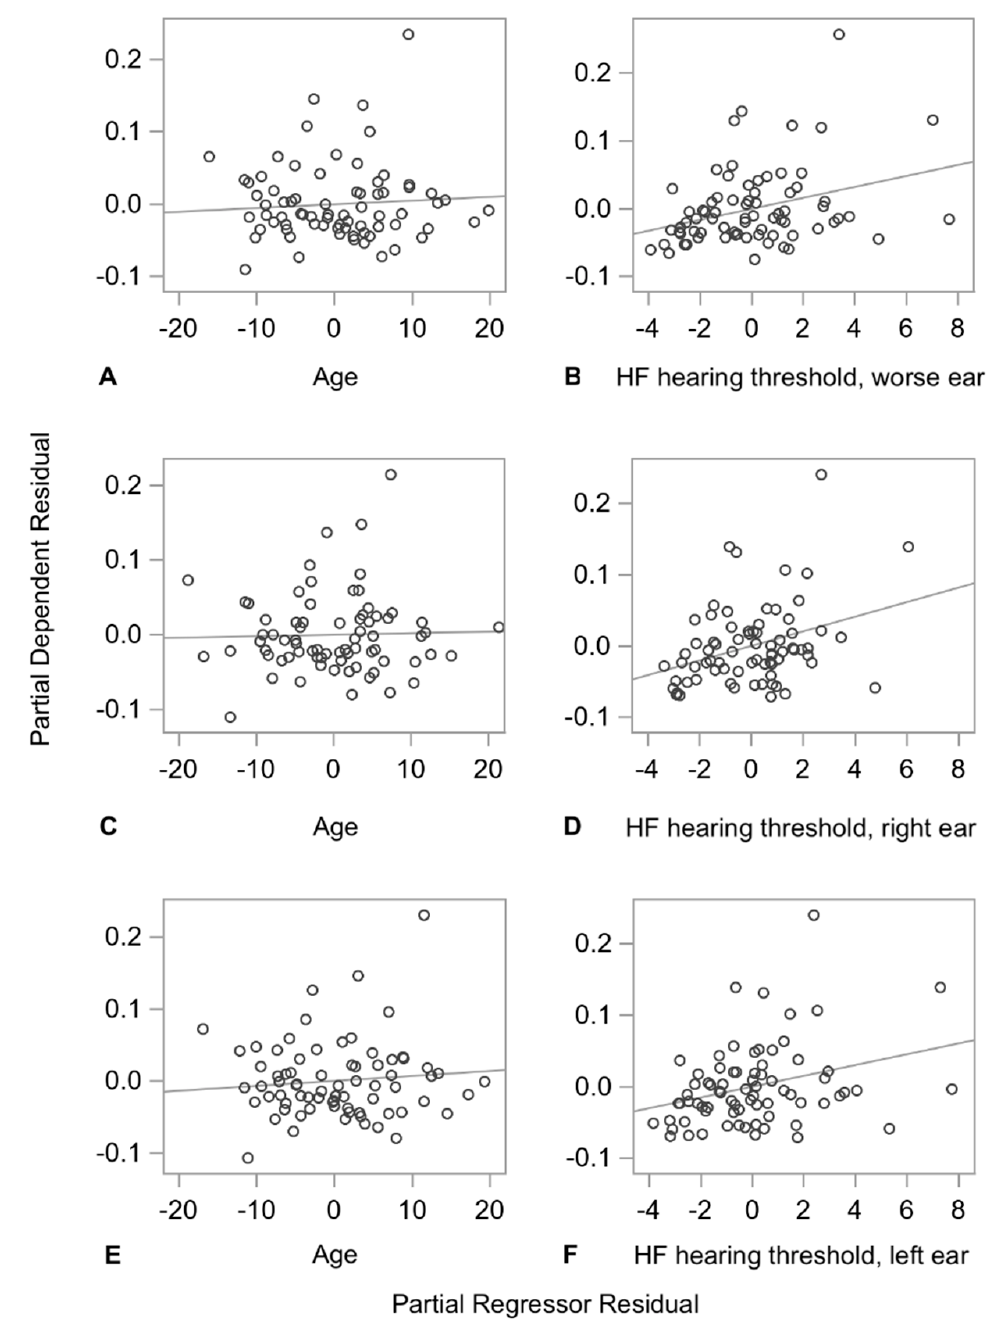
Figure 2. Partial regression plots for double support period (DSP) CV for age, and high frequency hearing thresholds for the poorer hearing ear, the right ear, and the left ear. Each plot illustrates the